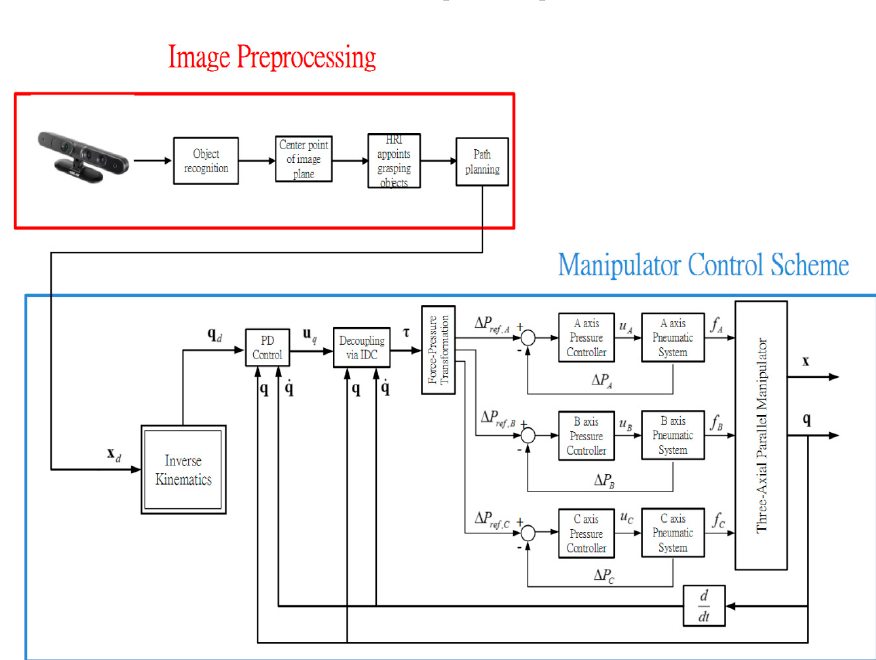
Figure 15. Overall manipulator system control scheme.